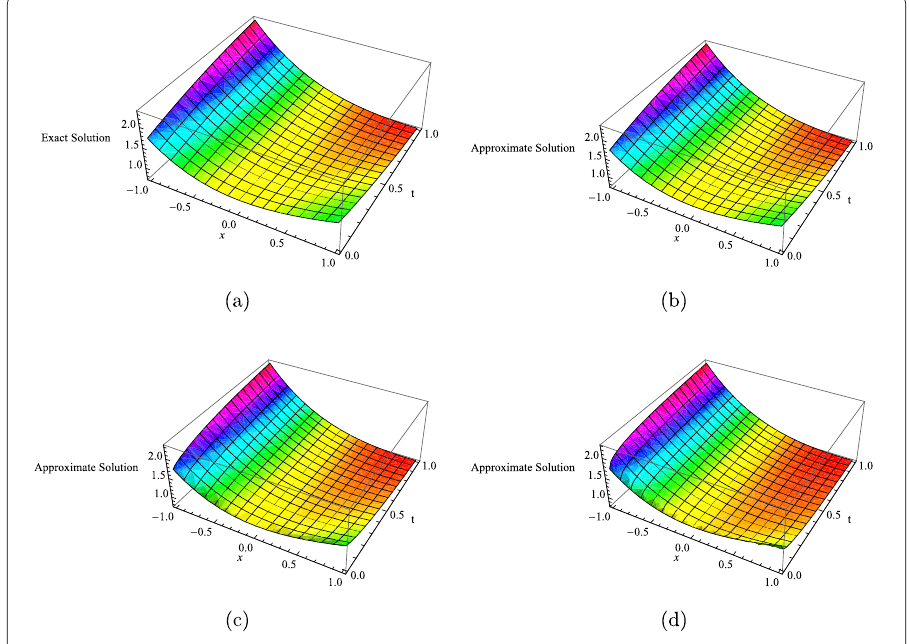
Figure 1 The surface graph of the exact solution u ( x , t ) and the seventh-order approximate solution u 7 ( x , t ) of Eq. (4.1): ( a ) u ( x , t ) when λ = 1, ( b ) u 7 ( x , t ) when λ = 1, ( c ) u 7 ( x , t ) when λ = 0.75, ( d ) u 7 ( x , t ) when λ = 0.5